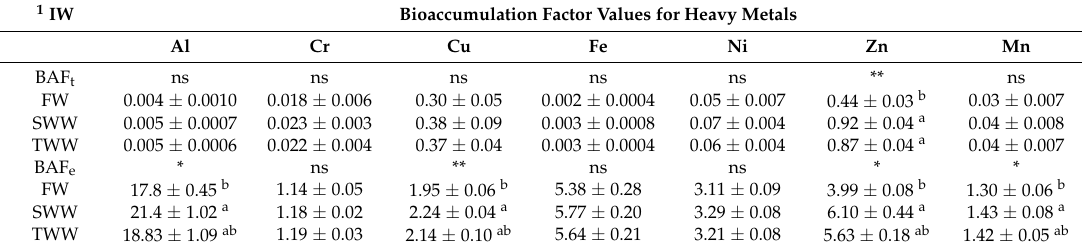
Table 5. Effect of the type of irrigation water used on bioaccumulation factors for the given heavy metals in the total (BAF t ) and DTPA-extractable (BAF e ) soil fractions. The data shown are the means ± standard errors for each heavy metal as determined for 6 samples (3 replicates × 2 growing